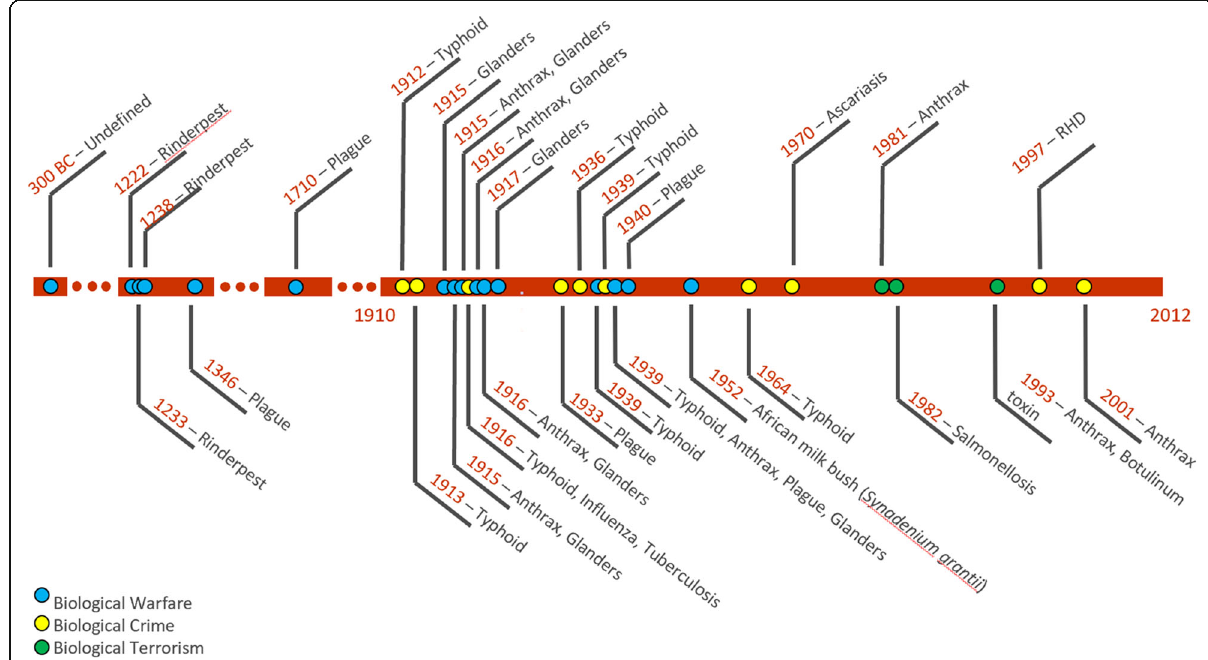
Fig. 5 Timeline showing confirmed use of animal pathogens or toxins used in biological warfare, biocrime or bioterrorism through the centuries (Developed by Keith Hamilton and Bruno